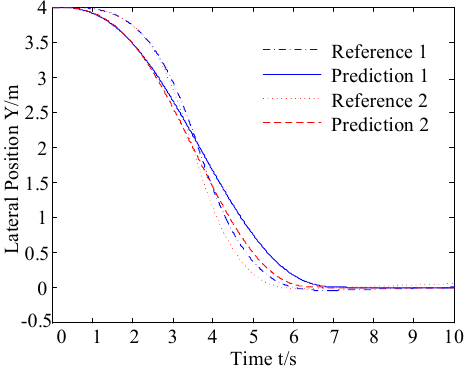
Figure 3. Comparison of reference trajectories and predicted trajectories.